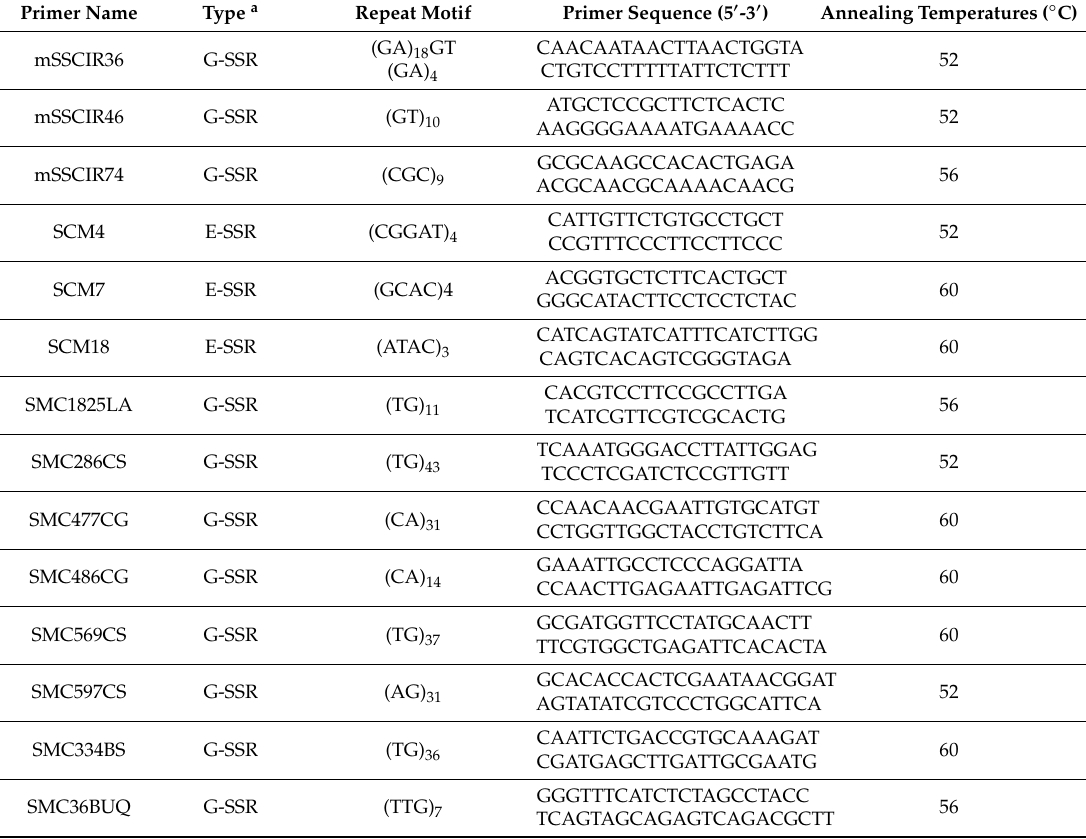
Table 2. The 21 simple sequence repeat (SSR) markers used in this